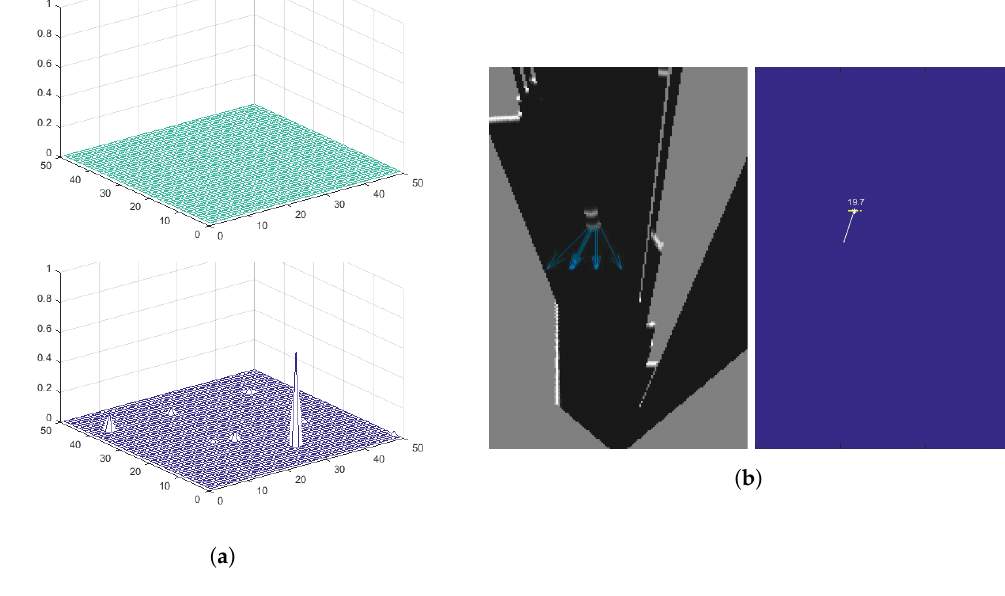
Figure 4. ( a ) Initial uniform probability distribution on the velocities (top) and convergence of probabilities (bottom), ( b ) clustering process grouping independent dynamic cells into